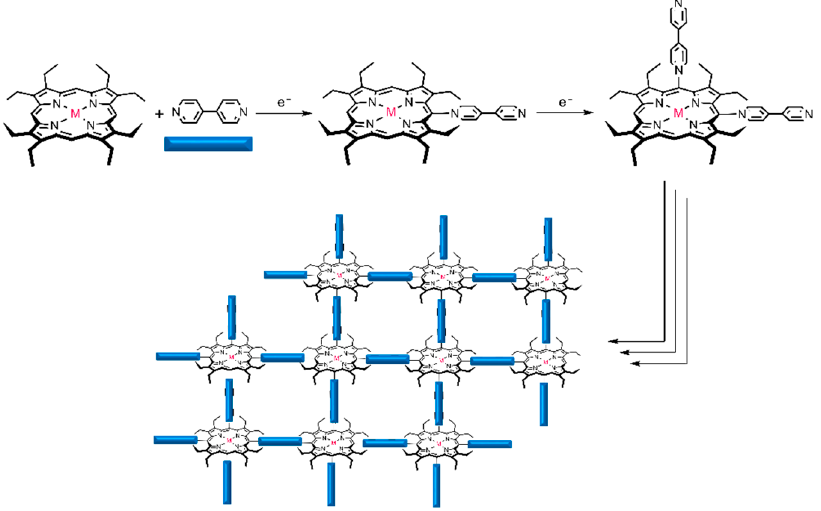
Figure 1. Representation of an alternating porphyrin–viologen copolymer creating a 2D layer.